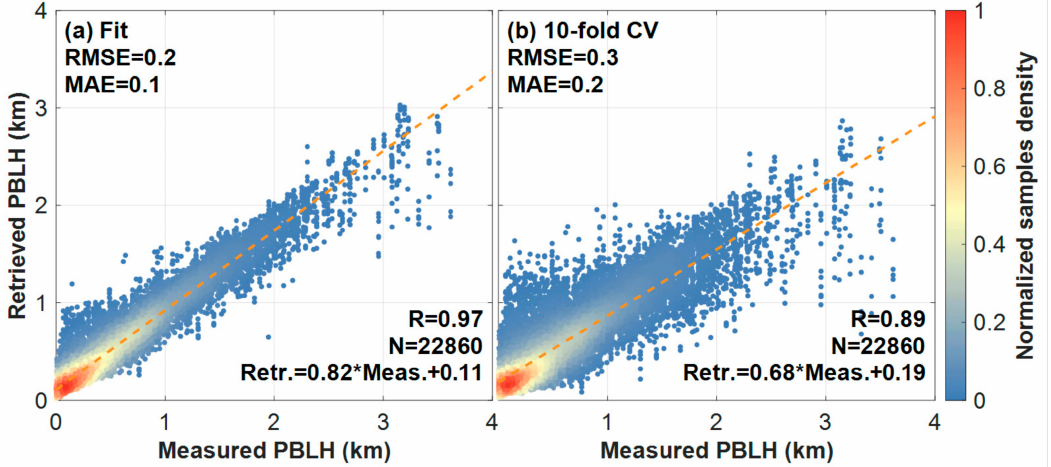
Figure 3. ( a ) PBLHs derived from BT model directly and ( b ) processing 10-fold CV method compared with PBLHs derived from the